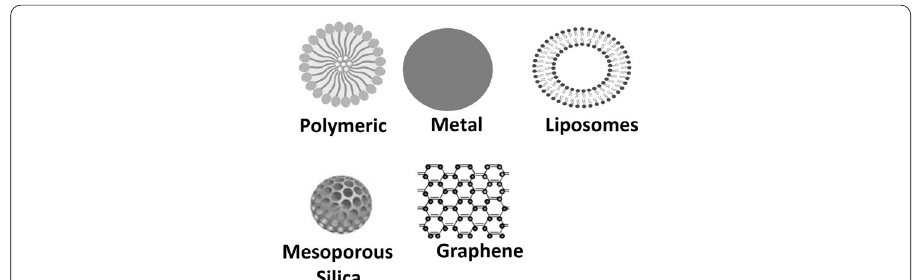
Fig. 2 Examples of nanomaterials available or under research worldwide, representing the main forms/ structures, including polymeric nanoparticles, metal nanoparticles (gold and silver mainly), liposomes, mesoporous silica, and graphene (and graphene derivatives, like graphene quantum dots and graphene